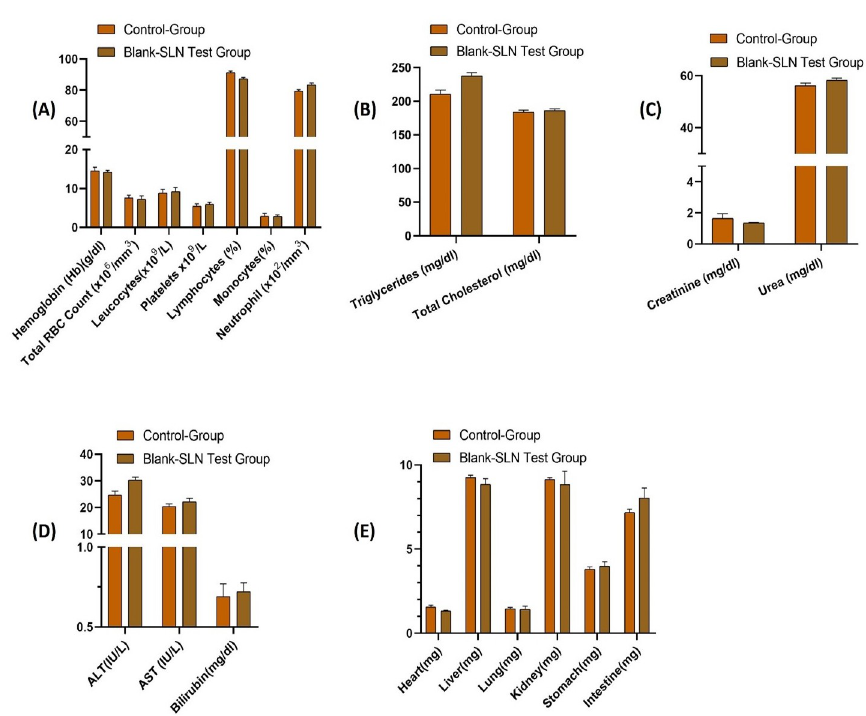
Fig 9. Analysis of biochemical and hematological parameters in the control group and blank SLN4 (test group). (A) hematological parameters, (B) lipid profile, (C) renal function test, (D) liver function test, (E) organ weight. All results indicate mean ± SD, ( n =